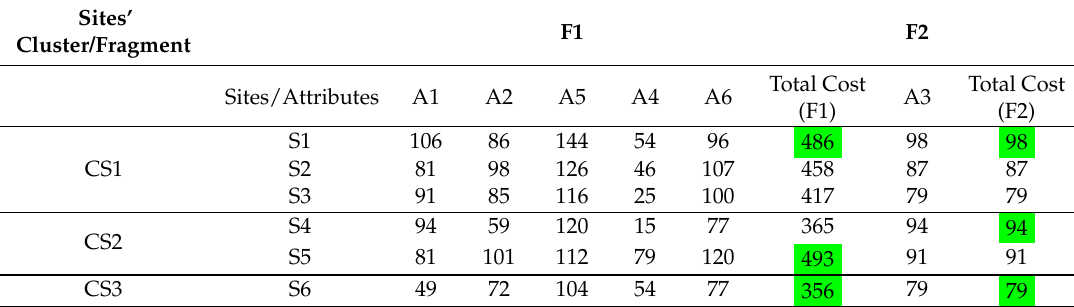
Table 14. Decision allocation matrix,